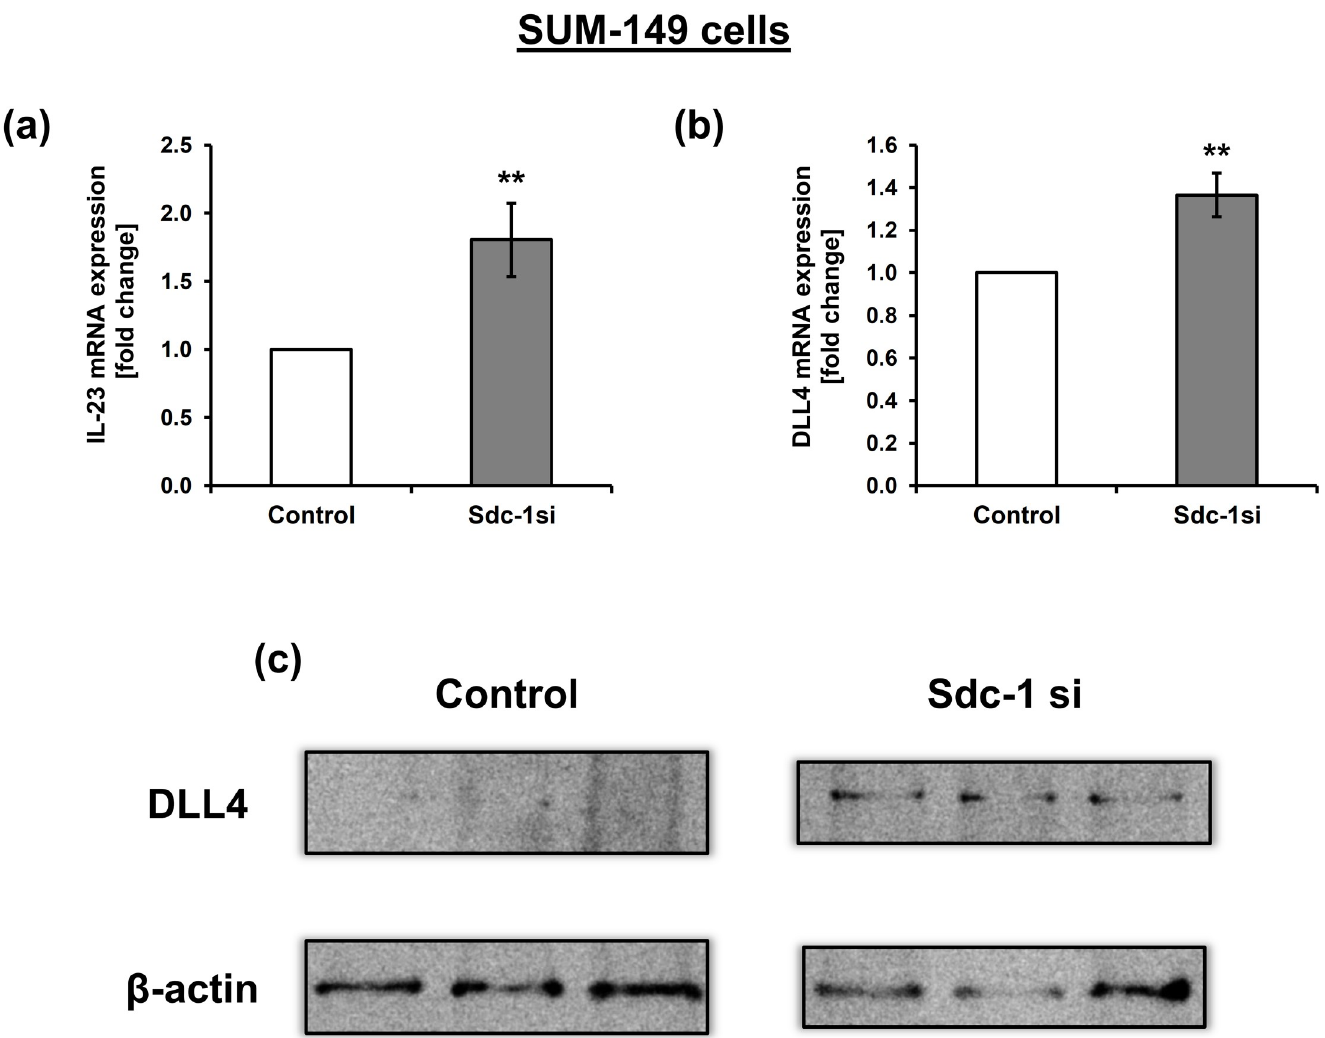
Fig 5. Sdc-1 silencing upregulates IL-23 and DLL4 expression in SUM-149 cells. 48 hours post transfection of SUM-149 with negative control and Sdc-1 siRNA, total RNA was extracted, reverse transcribed into cDNA and relative mRNA expression was quantified by qPCR. mRNA expression of a) IL-23, and b) DLL4 in control and Sdc-1-silenced SUM-149 cells. c) Western blot shows upregulation of DLL4 protein expression in Sdc-1-silenced SUM-149 cells relative to control. Data represent mean ± SEM, n � 3, �� P < 0.01 as determined by Student’s t test.